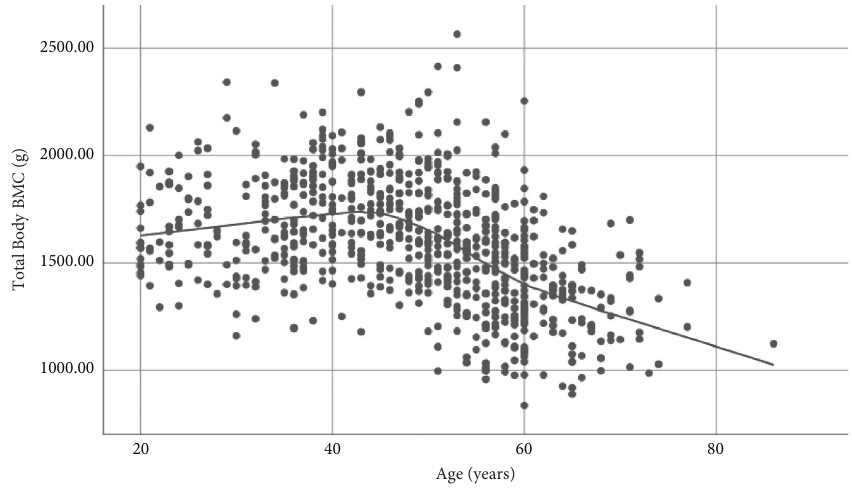
Figure 2: Age-related trend of TBBMC. Table 2: Body composition measurements in different age group.